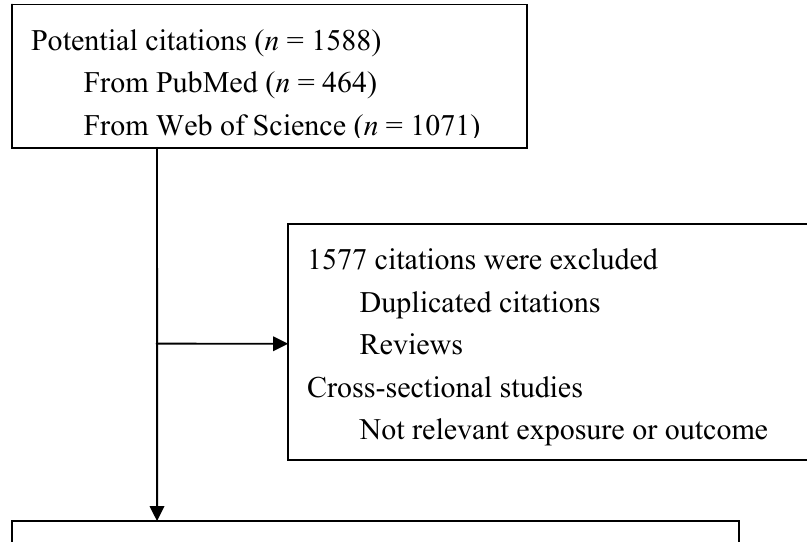
Figure 1. Flow chart of literature search and study